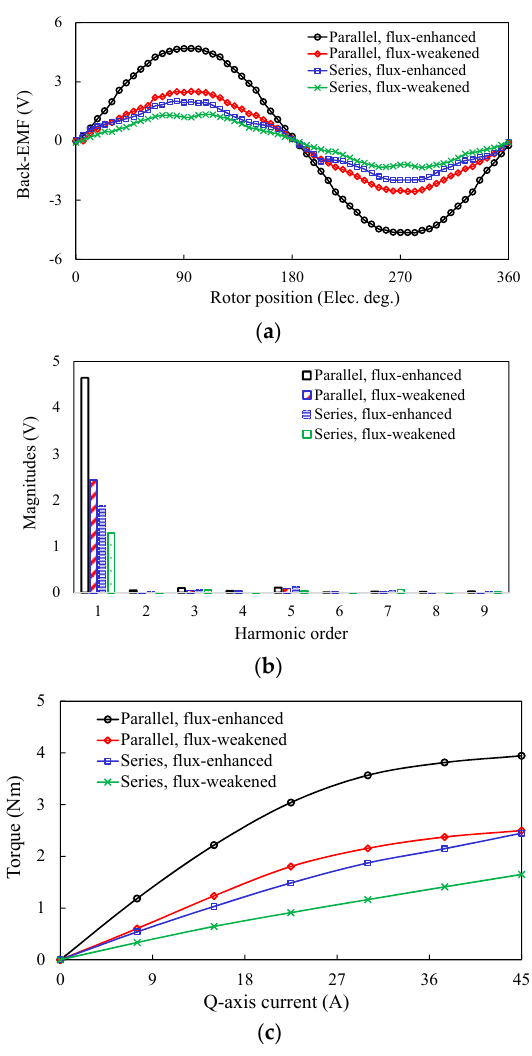
Figure 4. Key electromagnetic characteristics of PS-SF-HMMMs with parallel and series magnetic circuits. ( a ) Open-circuit EMF waveforms; ( b ) EMF harmonic spectra; ( c ) Torque-current curves.